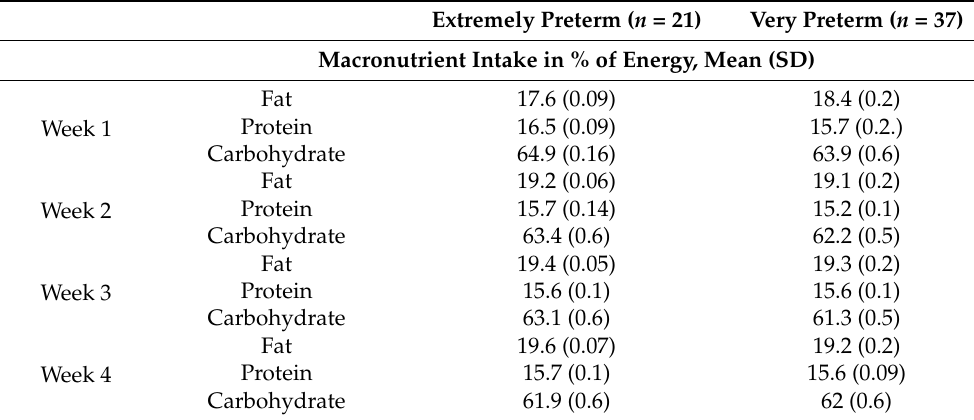
Table 3. Macronutrient intake (% energy) in extremely and very preterm infants during the first four weeks of